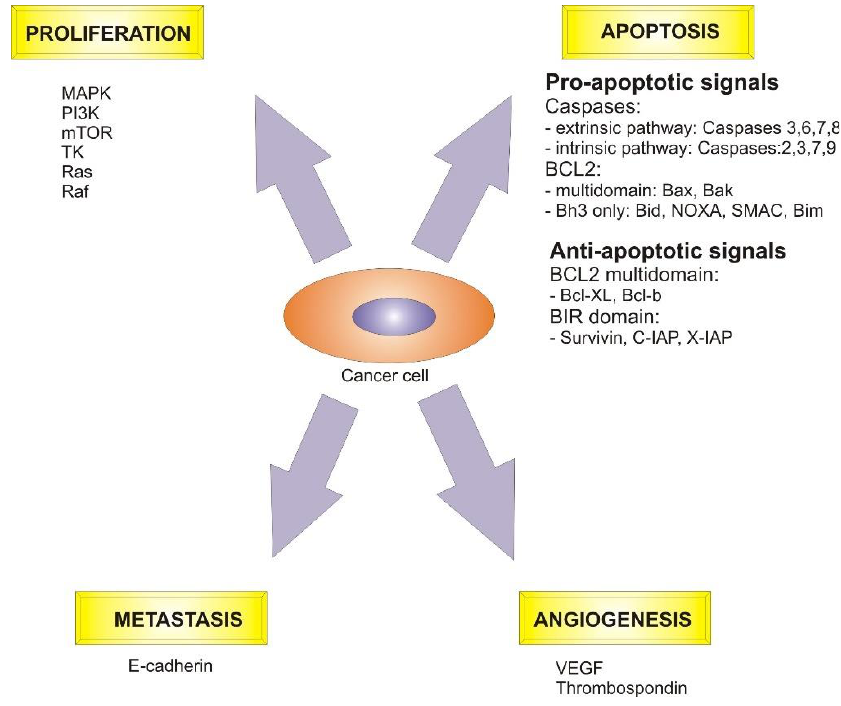
Figure 2. Critical signaling pathways and mediators involved in the cancer cell regulation. Abbreviations: MAPK—mitogen-activated protein kinase, PI3K—phosphoinositide 3-kinases, mTOR—mammalian target of rapamycin, TK—tyrosine kinases, Ras—rat sarcoma virus proteins, Raf—rapidly accelerated fibrosarcoma protein, SMAC—soluble membrane attack complex, C-IAP and X-IAP—inhibitors of apoptosis, VEGF—vascular endothelial growth